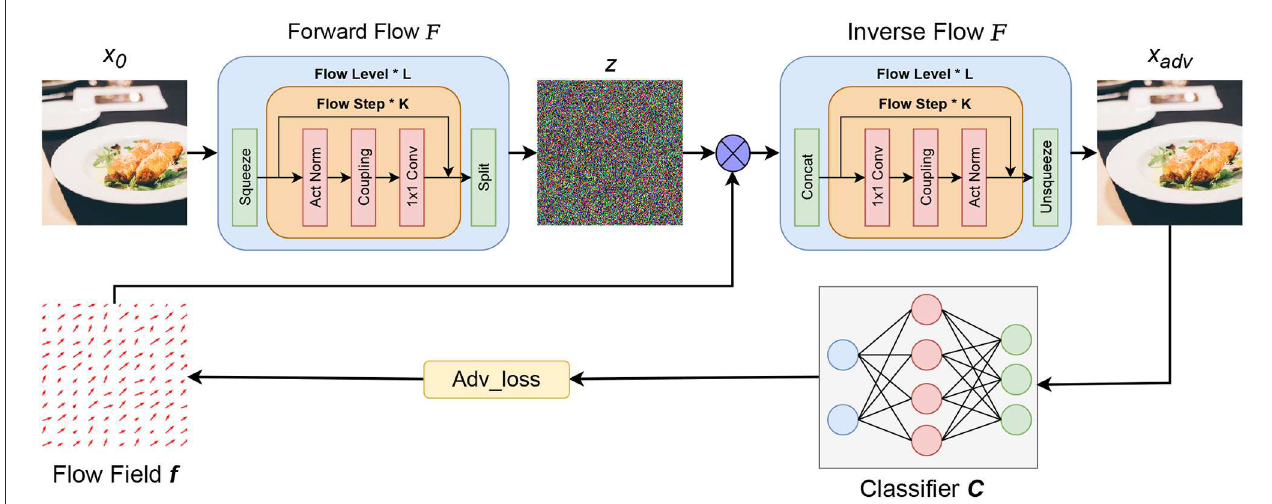
FIGURE2 The framework of proposed DualFlow. x represent the image, among them, x 0 is the benign image, x adv is the corresponding adversarial counterpart; z is the hidden representation of the image; F is the well-trained Normalize Flow model and C is the pre-trained classifier; f is the flow field need to be optimized and ⊗ represents the spatial transform